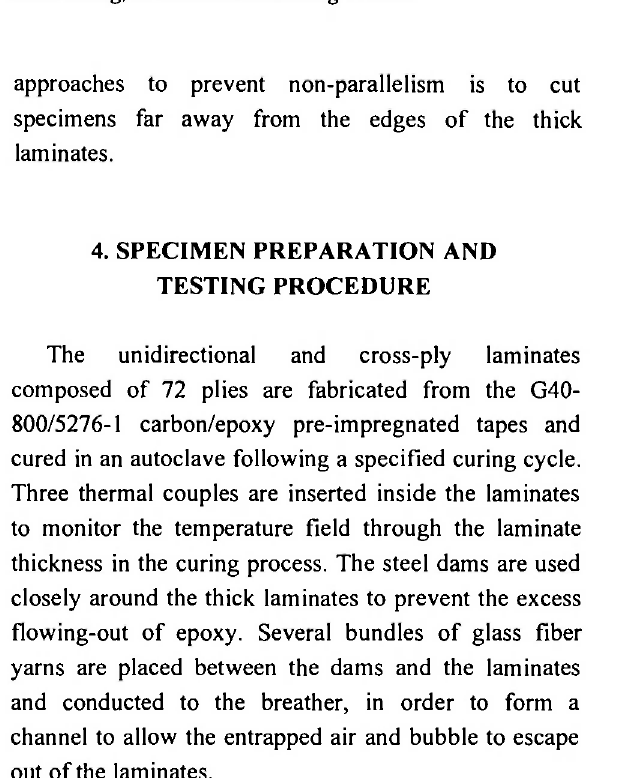
Fig. 10: Typical stress-strain curve for unidirectional